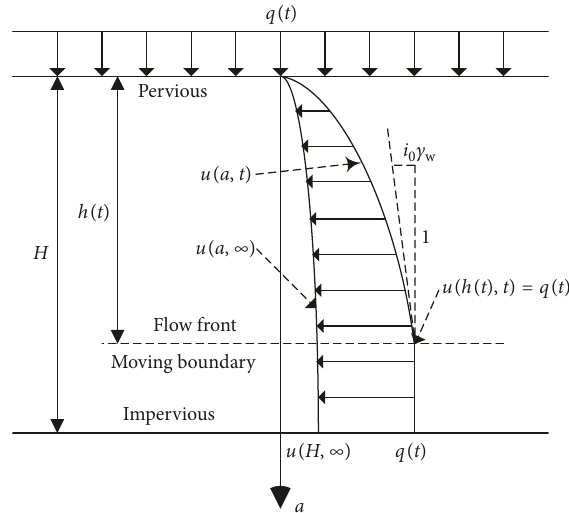
Figure 3: Analysis of moving boundary in the Lagrangian coordinate.